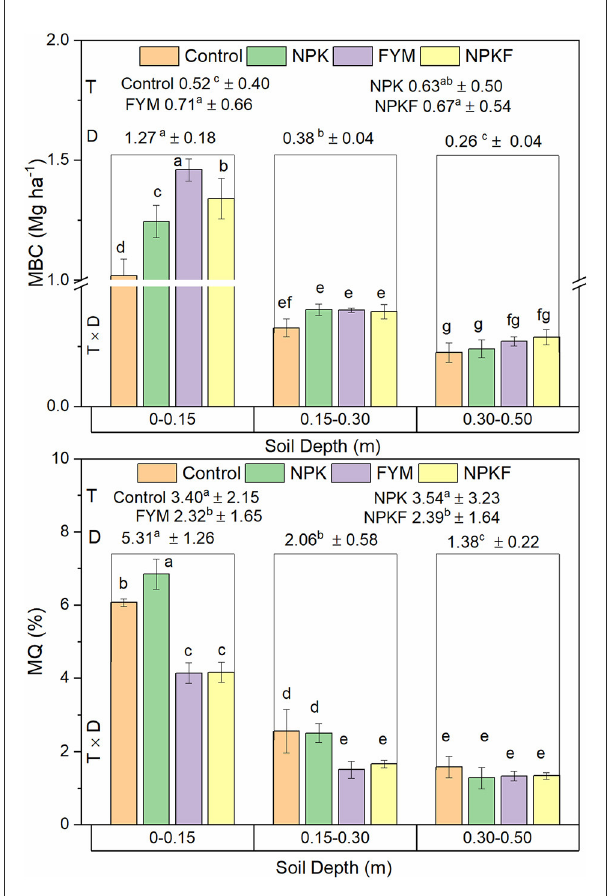
FIGURE1 Effect of nutrient management (T), depth (D), and their interaction (T × D) on microbial biomass carbon and microbial quotient; capped lines on bars are standard deviations; n = 9, 12, and 3 for T, D, and T × D, respectively; numbers and bars followed by different letters (a–f) are significantly different ( P <